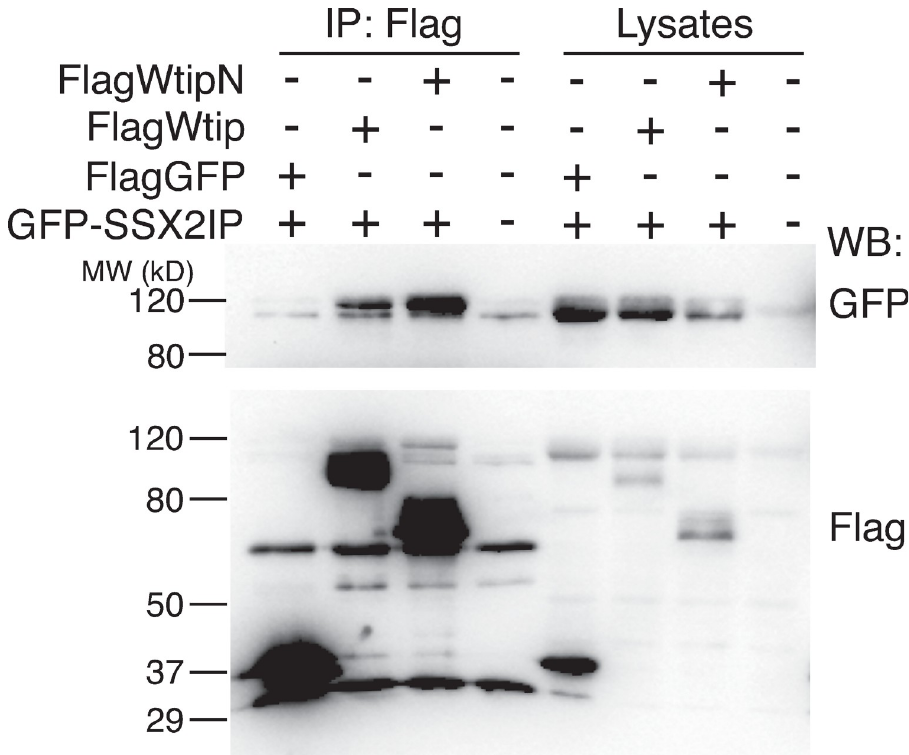
Fig 4. The physical association of SSX2IP and Wtip. Four-cell embryos were coinjected with GFP-hSSX2IP RNA and either Flag-WtipN or Flag-Wtip RNA (300 pg each). Flag-GFP RNA (300 pg) was the negative control. Embryos were lysed at stage 11 and lysates were immunoprecipitated with anti-Flag agarose beads and immunoblotted with antibodies specific for Flag and GFP. WtipN coprecipitated with SSX2IP more efficiently than full length Wtip.